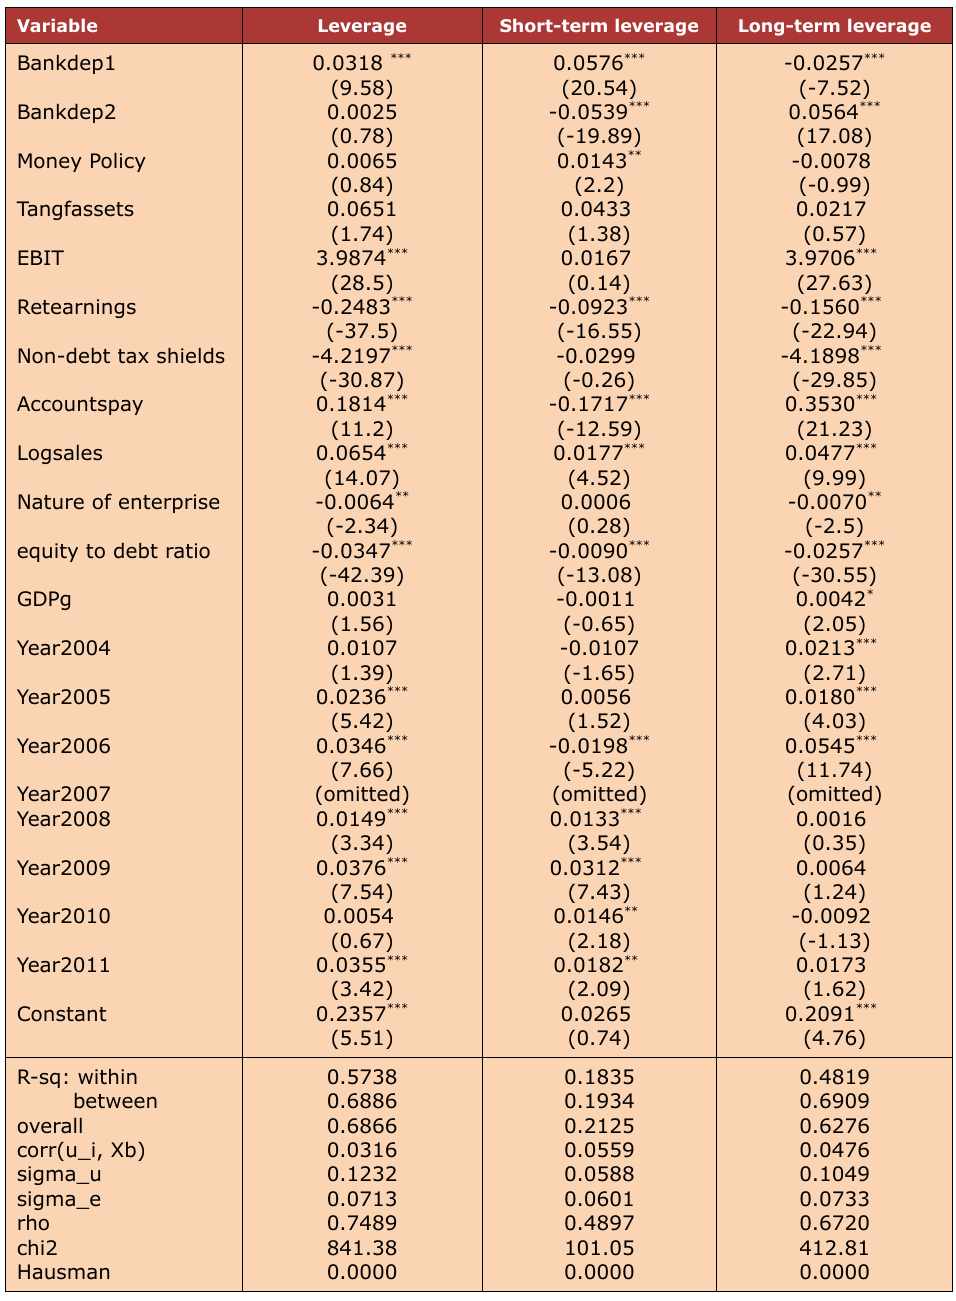
Table 7. Fixed-effects Regression of